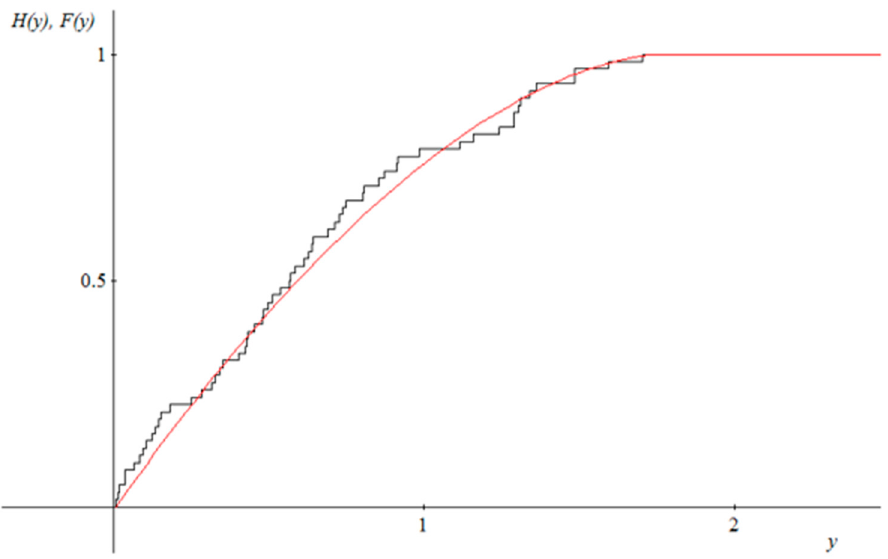
Figure 2. Graph showing the empirical cumulative distribution (black) ˆ F ( y 2 ) and fitting the theoreti- cal cumulative distribution H γ , µ , σ ( y 2 )